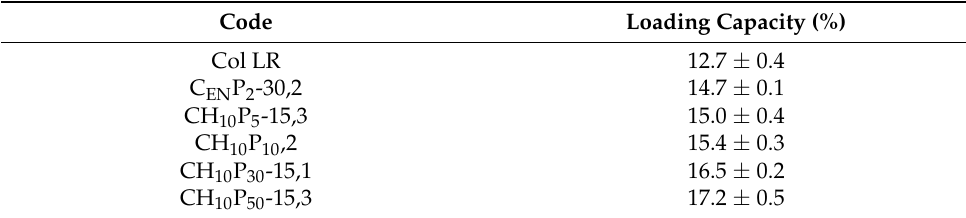
Table 3. Curcumin loading capacity of the investigated